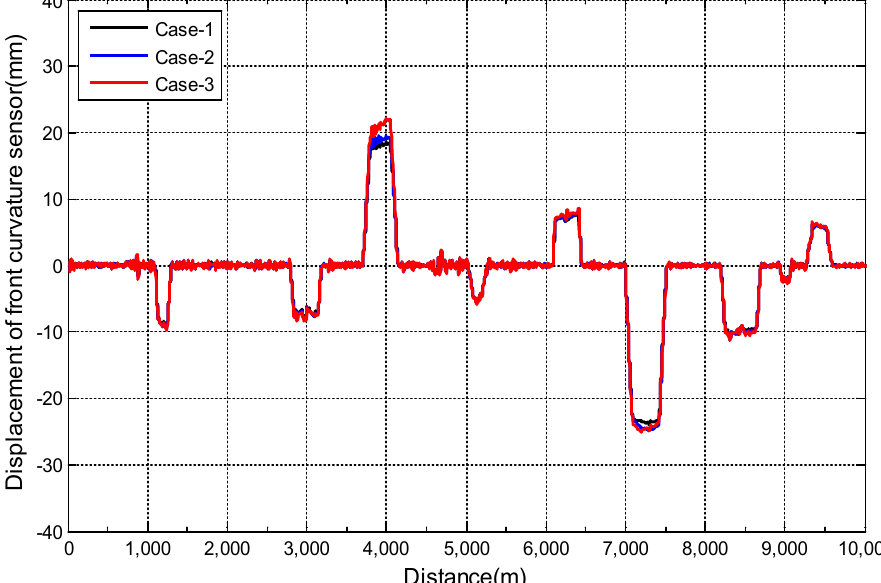
Figure 6. Displacement of front curvature sensor from simulation.